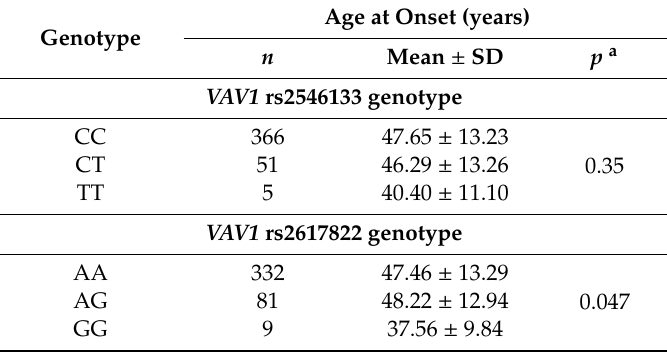
Table 3. Analysis of the age at onset in relation to VAV1 rs2546133 and rs2617822 genotypes. Genotype